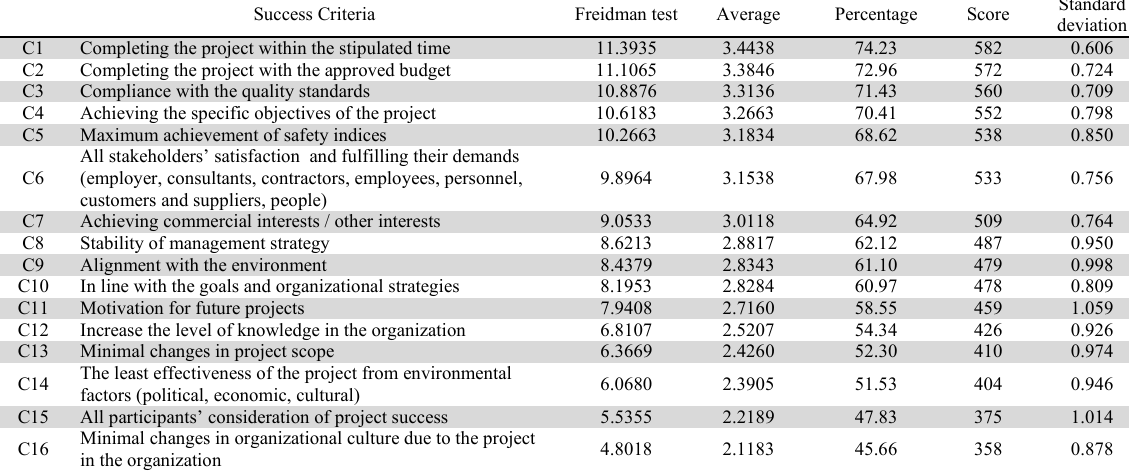
Acquired ranks by